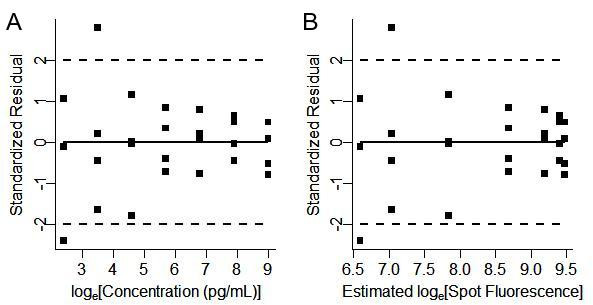
Modeling diagnostics The points in graphs of the standardized residuals versus the loge standard concentrations (A) and the standardized residuals versus the estimated loge spot intensities (B) are reasonably well behaved, showing no strong systematic trends or deviations from the zero line. These indicate that the four-parameter logistic model is acceptable, that subsequent statistical inferences are reasonable, but that a better model may exist in another model family.